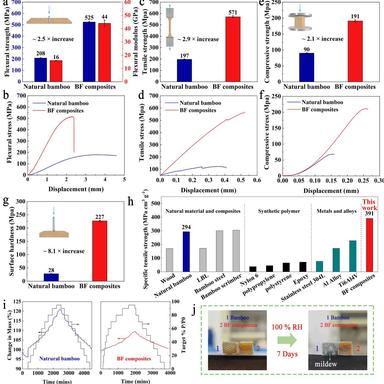
Mechanical and physical performance of natural bamboo and BF composites. (a) Flexural strength, modulus, and (b) stress-displacement curves of natural bamboo and BF composites. (c) Tensile strength and (d) stress-displacement curves of natural bamboo and BF composites. (e) Compressive strength and (f) stress-displacement curves of natural bamboo and BF composites. (g) Surface hardness of natural bamboo and BF composites. (h) Comparison of specific tensile strength of BF composites (391 MPa) with natural mat